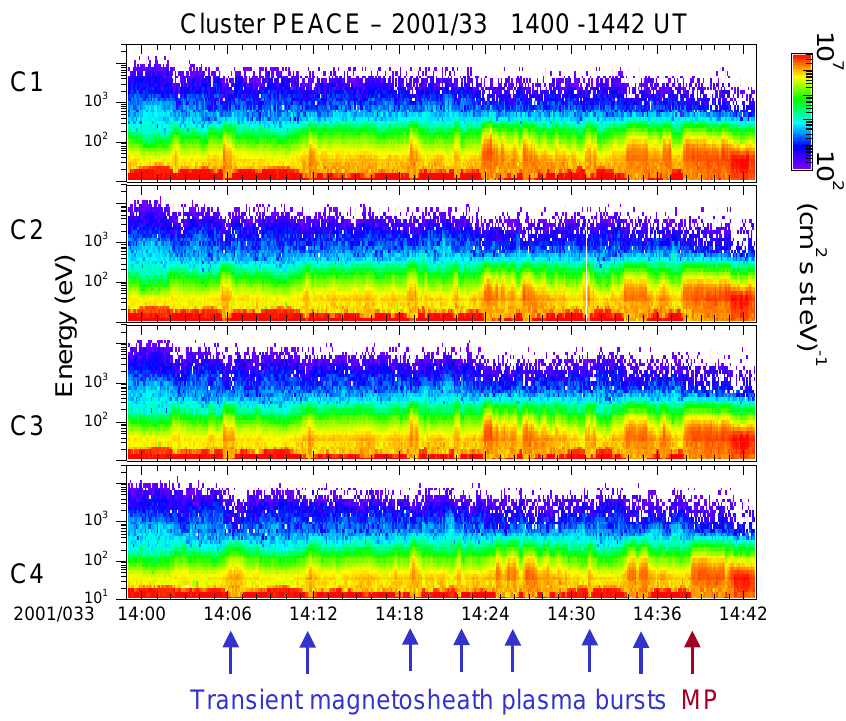
Fig. 3. PEACE energy-time spectrograms for the period from 14:00–14:42 UT on 2 February 2001. As the spacecraft approach the magne- topause, indicated by the red arrow at the bottom of the figure, a series of transient bursts of magnetosheath-like electrons are observed by each of the PEACE instruments (blue arrows). These occur every 4–6min, which is consistent with the occurrence rate of magnetospheric flux transfer